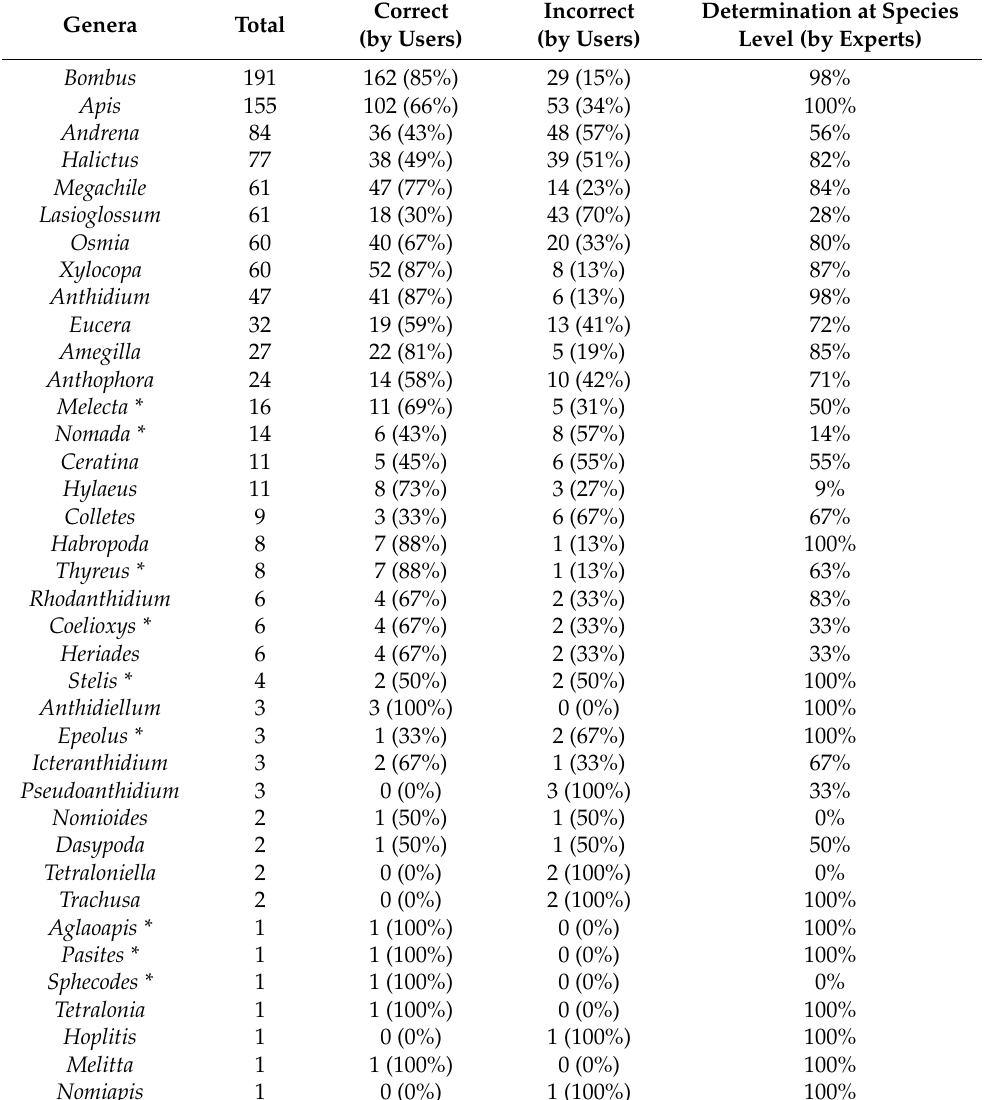
Table 1. Number (and percentage) of correct and incorrect determination at genus level by the users; in the last column, percentage of records for which species attribution by the experts was possible. (* kleptoparasite